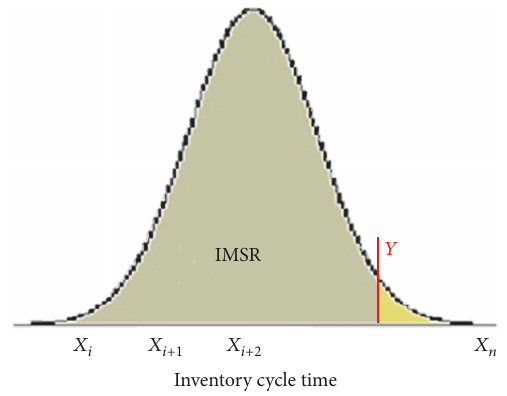
Figure 2: Typical IMSR phenomenon.